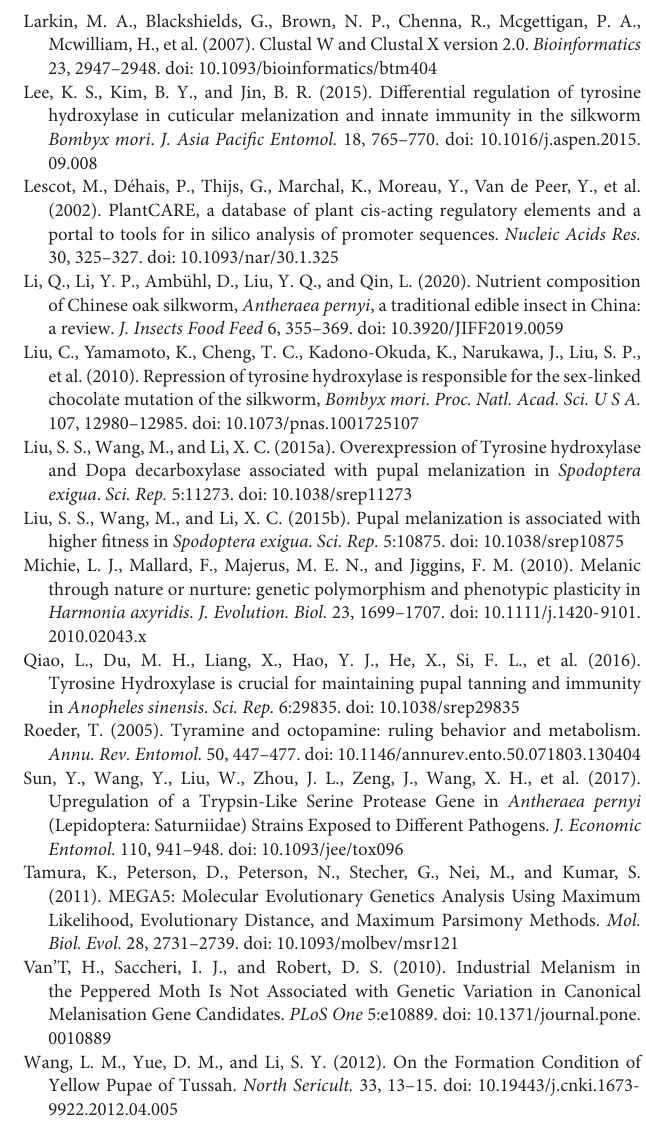
Supplementary Figure 1 | Complementary cDNA and deduced amino acid sequence of ApTH. The initiation and termination codons, ATG and TAA, respectively, are indicated in bold; TAA is marked with an asterisk (A) . Exons in ApTH gene protein-coding region in DNA sequence (B) . Supplementary Figure 2 | Complementary sequence and predicted amino acid sequence of ApDDC (A) , and Exons in ApDDC gene protein-coding region in DNA sequence (B)